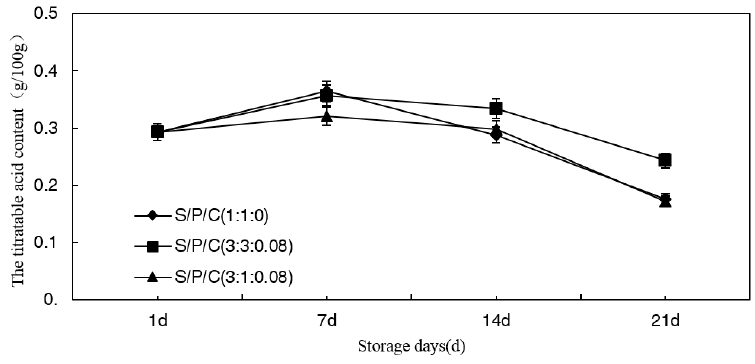
Figure 6. Effect of starch/polyvinyl alcohol/citric acid ternary blend functional food packaging films on the TA.